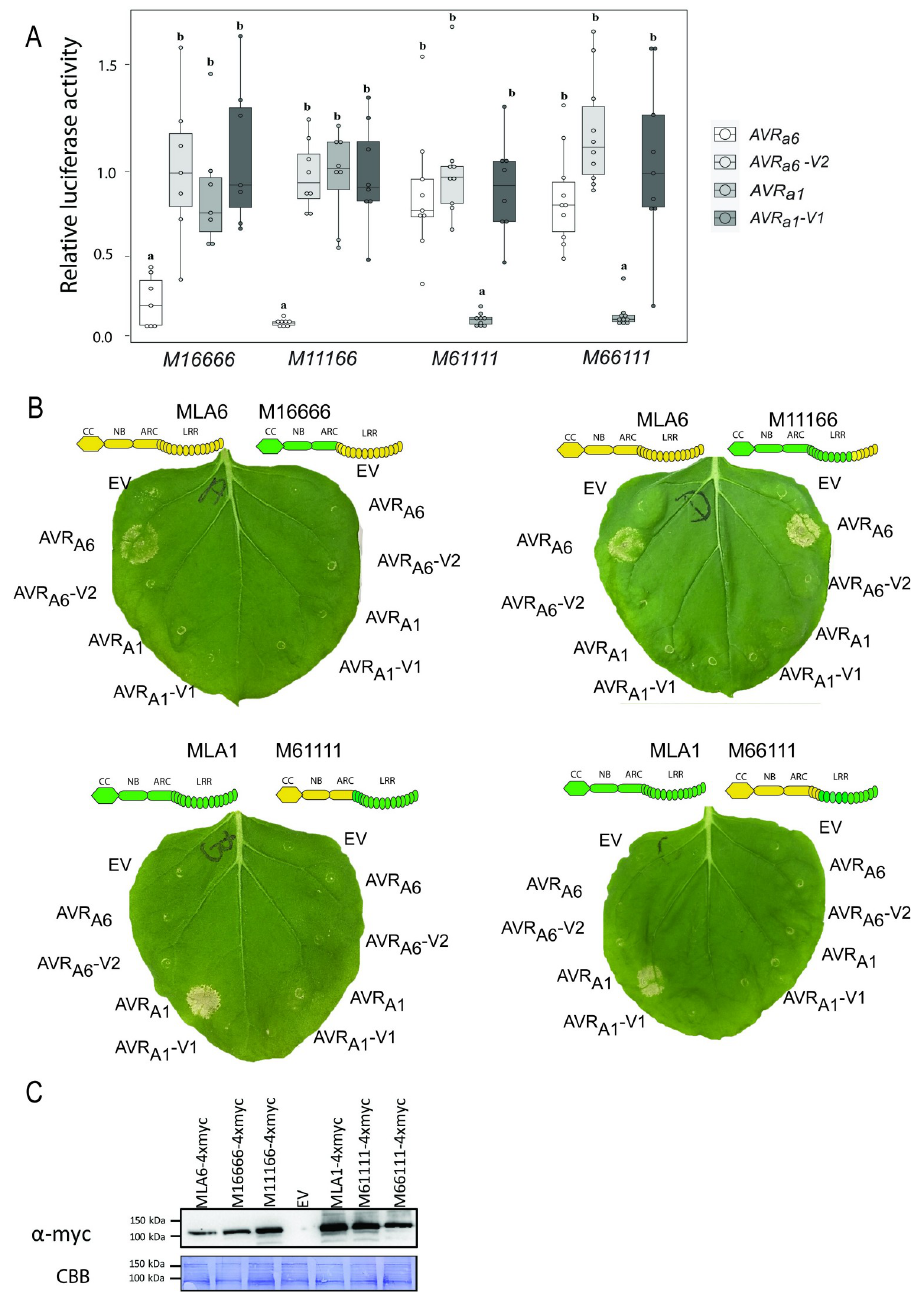
Fig 5. Specific recognition of AVR A6 and AVR A1 by MLA1/MLA6 chimeric constructs in planta . (A) Barley cv . Golden Promise protoplasts were transfected with a LUC reporter construct and pIPKb002 vectors containing cDNAs of AVR a6 , AVR a6 -V2 , AVR a1 , AVR a1 -V1 or an empty vector (EV) together with vectors harboring intron-containing DNA of receptor chimeras M16666 , M11166 , M61111 , or M66111 under the control of a pZmUBI promotor. Transfections were performed at least seven times independently. Significant differences between samples were analyzed using non-parametric Kruskal-Wallis (KW) analysis followed by a Dunn’s test. Calculated KW p-values are as follows: M16666 : p = 0.001883; M11166 : p = 0.000559, M61111 : p = 0.0001582, M66111 : p = 1.658e-05. Samples labeled with identical letters did not differ significantly ( p < 0.05) in the Dunn’s test for the corresponding Mla variant. (B) Transient transformation of N . benthamiana leaves with empty vector (EV) or cDNAs of AVR fused C-terminally with a mYFP tag together with Mla1 or Mla6 cDNAs or M16666 , M11166 , M61111 , or M66111 intron-containing DNAs with a C-terminal 4xmyc fusion. All constructs were expressed from a 35S promotor. Figures show a representative of at least three independent co-transformations. (C) MLA-4xmyc proteins were extracted